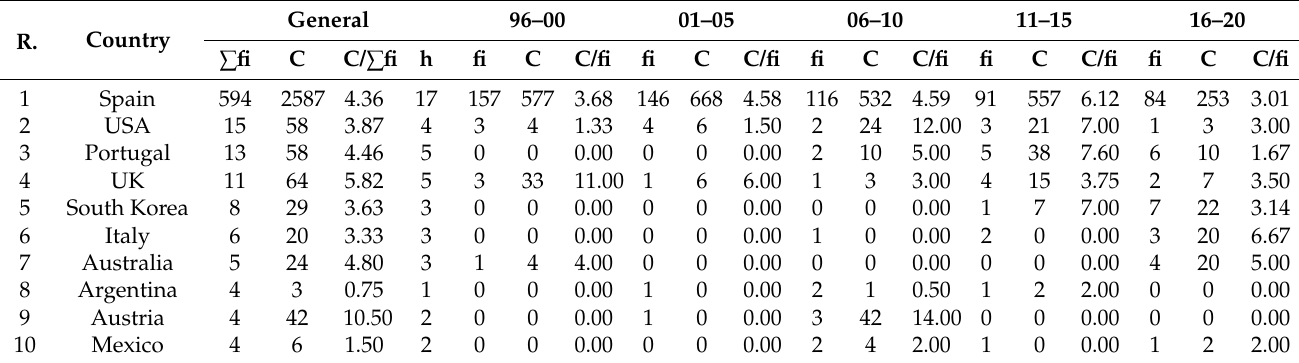
Table 9. Ranking of the countries of origin of the articles published in SJFA.